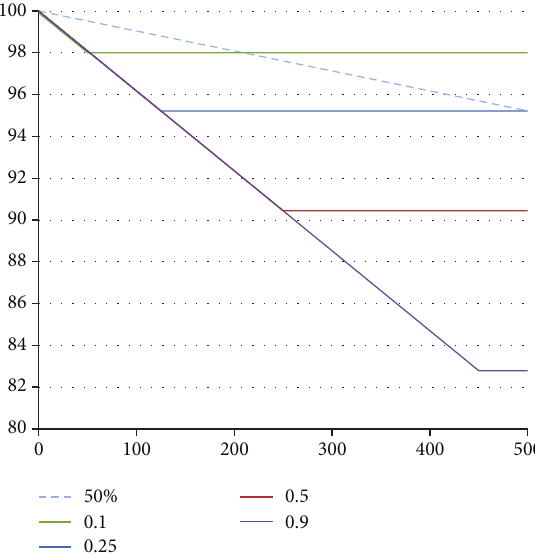
Figure 5: HGLs depending on the location of a single withdrawal in the line and HGL (dashed line) corresponding to the 50% allocation rule.